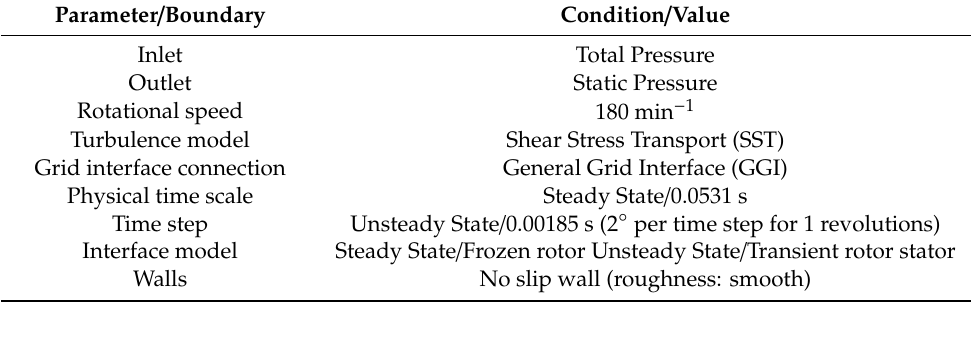
Table 8. Summary of boundary conditions for CFD analysis.